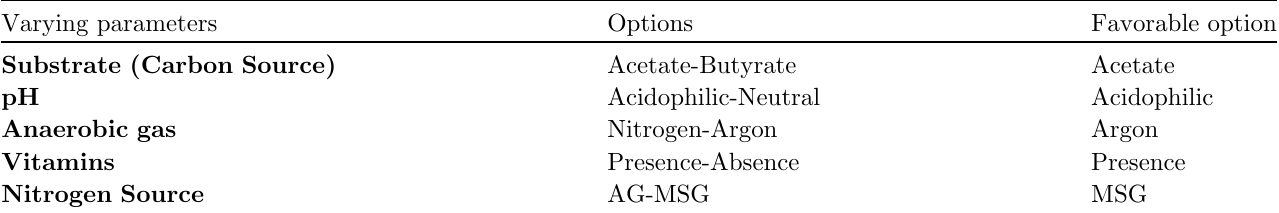
Table 10. Selection of the favorable option based on the experiments ’ conclusions [10]. Varying